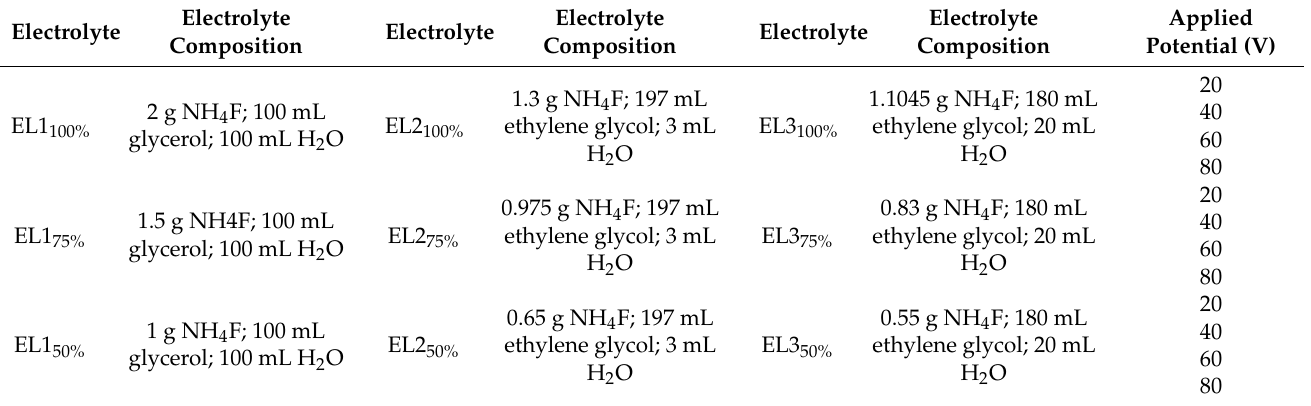
Table 1. Summary: electrolyte abbreviation, composition, and applied